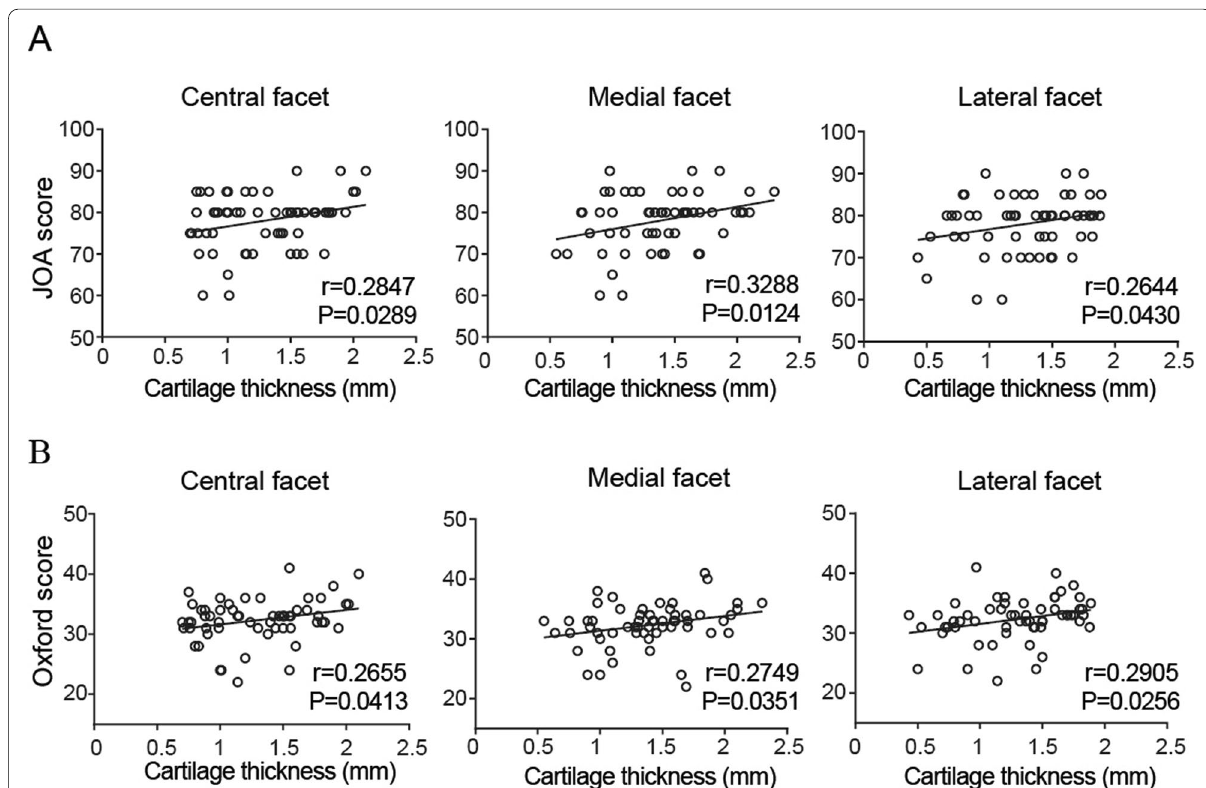
Fig. 4 Correlations between cartilage thickness and functional knee score. Correlation analyses between cartilage thickness in the patella (central, medial, and lateral facets) and ( A ) JOA score and ( B ) Oxford knee score 5 years after total knee arthroplasty. JOA score, Japanese Orthopedic Association